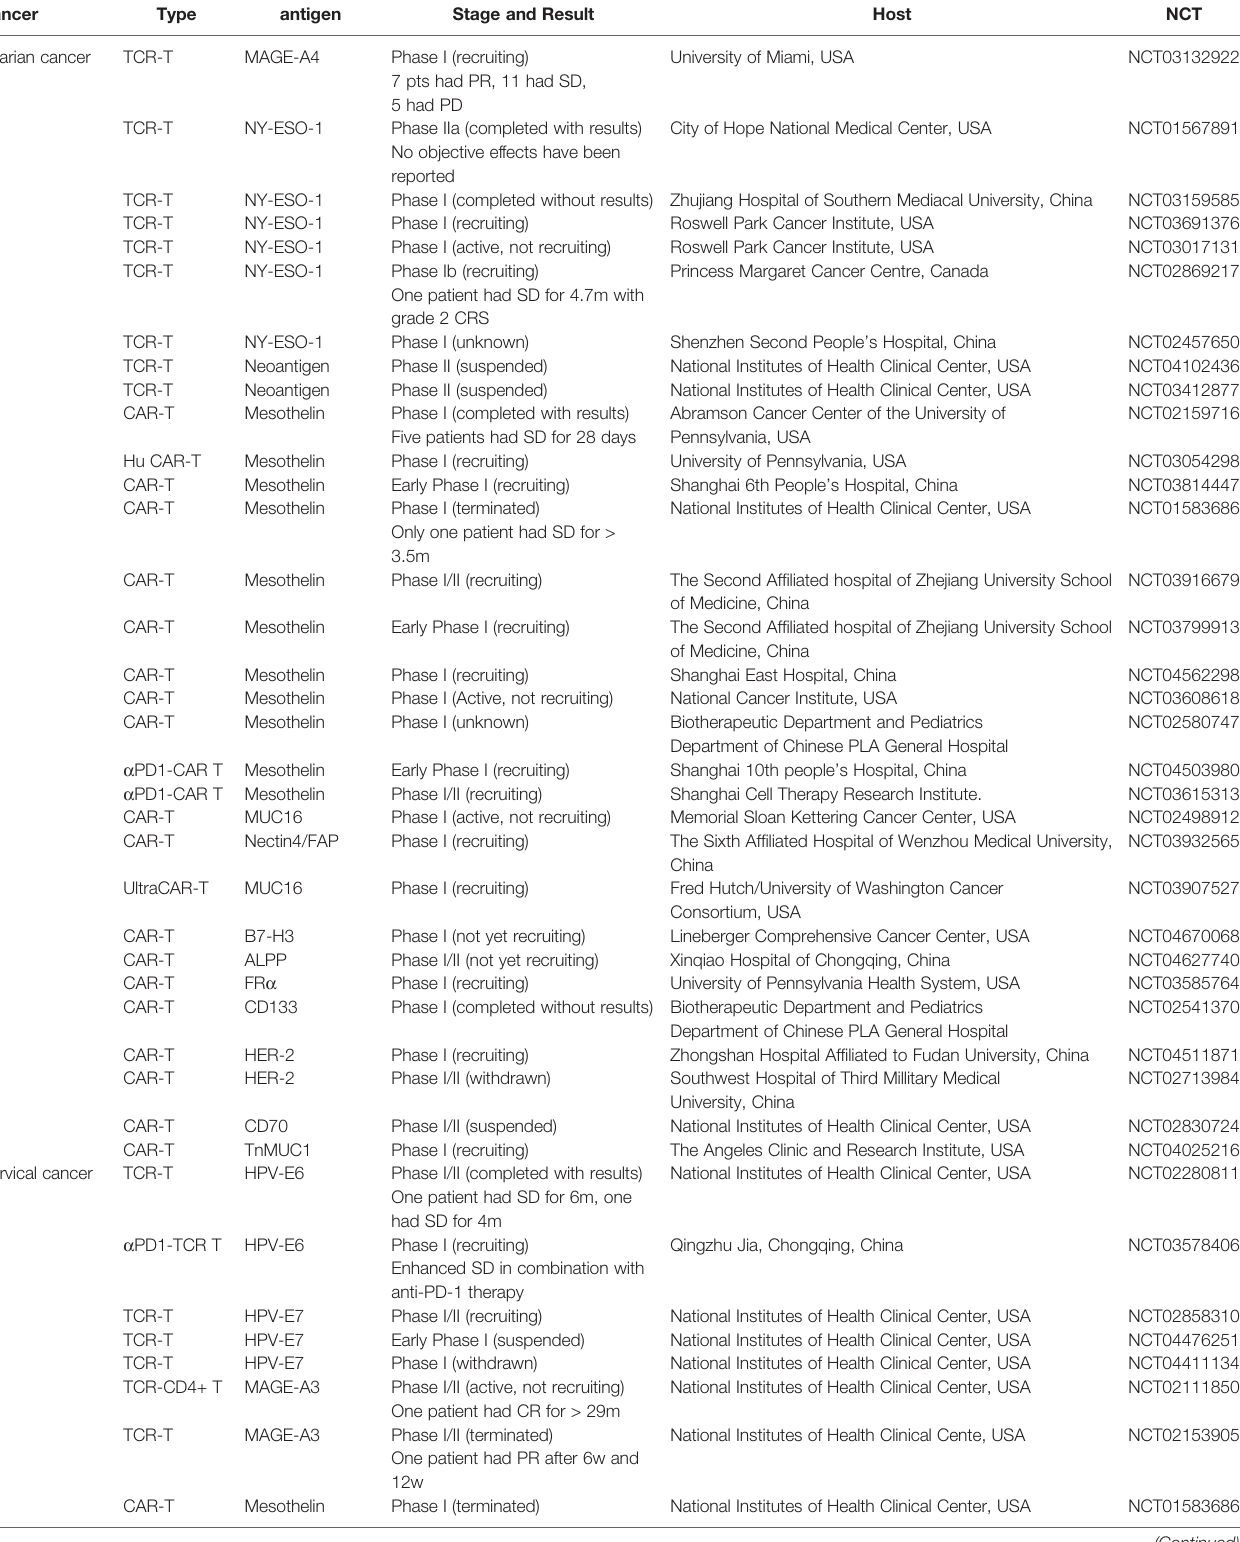
TABLE 1 | Clinical trials of engineered T cells in gynecologic cancer immunotherapy